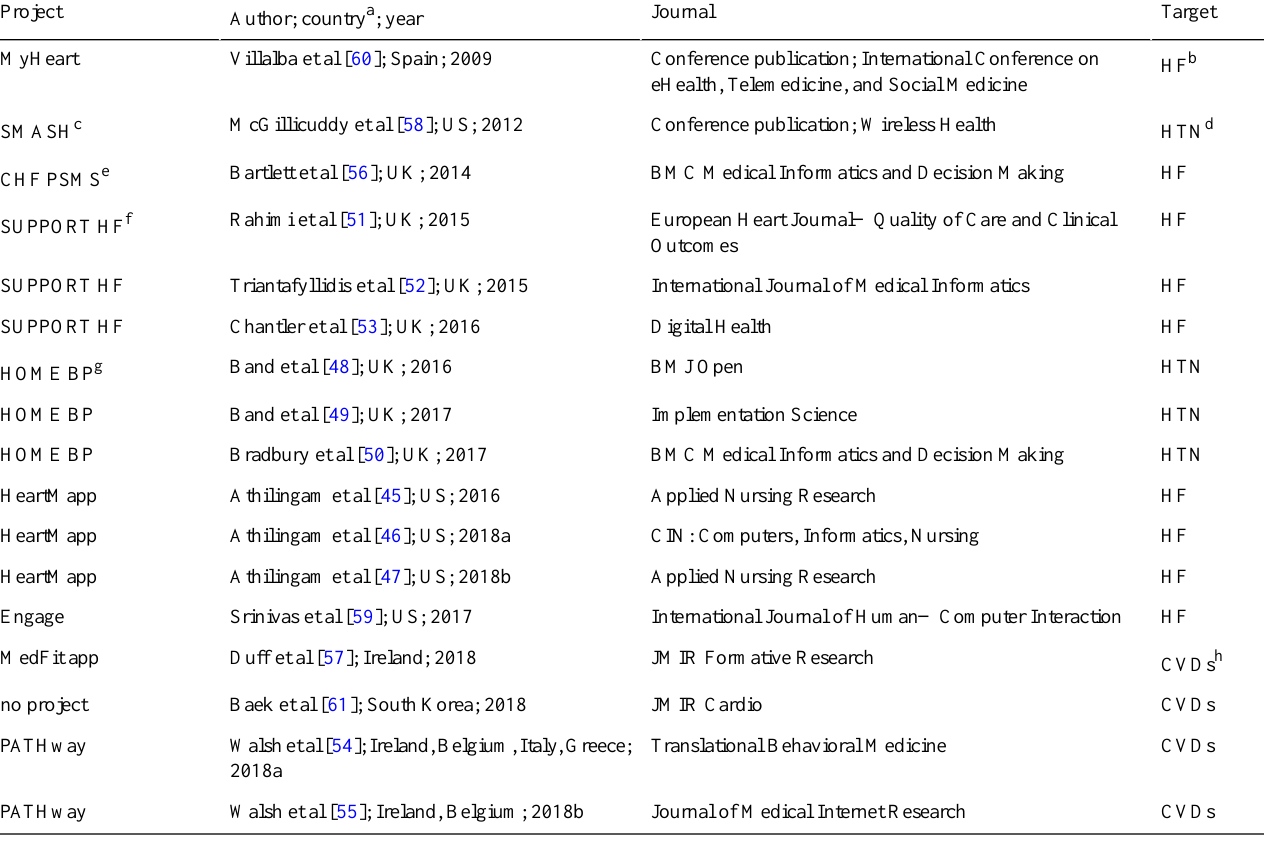
Table 1. Characteristics of included